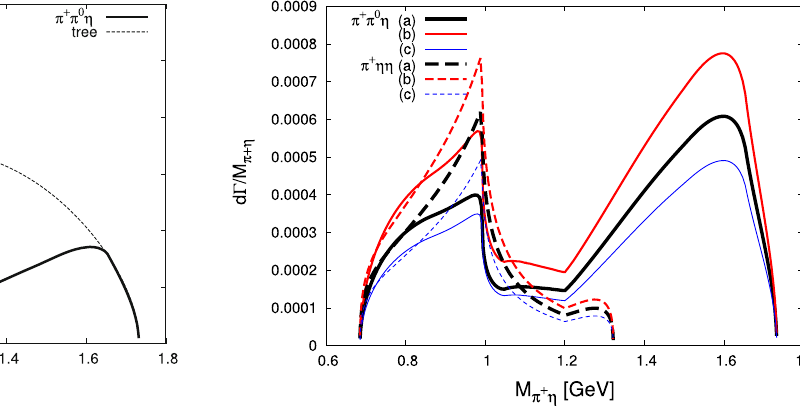
Fig. 8 Solid line: Result for d (cid:10)/ dM inv (π 0 η) for D + → π + π 0 η . The dashed curve stands for the phase space of D + → π + π 0 η . Same set of parameters as in Fig. 7.